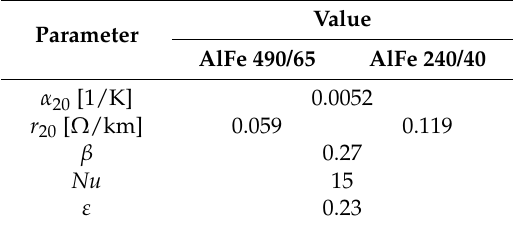
Table 1. Conductor model parameters from the catalogue [29].